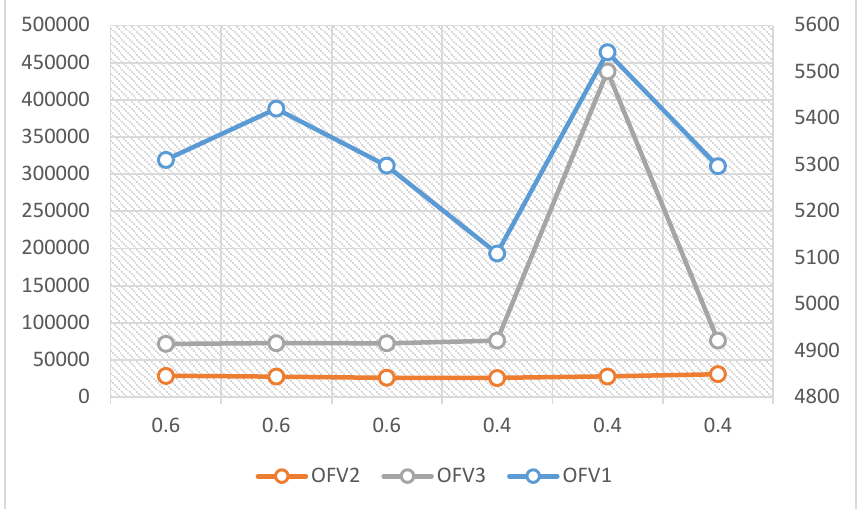
Figure 9. Objective function values of the TH method for test problem 2.